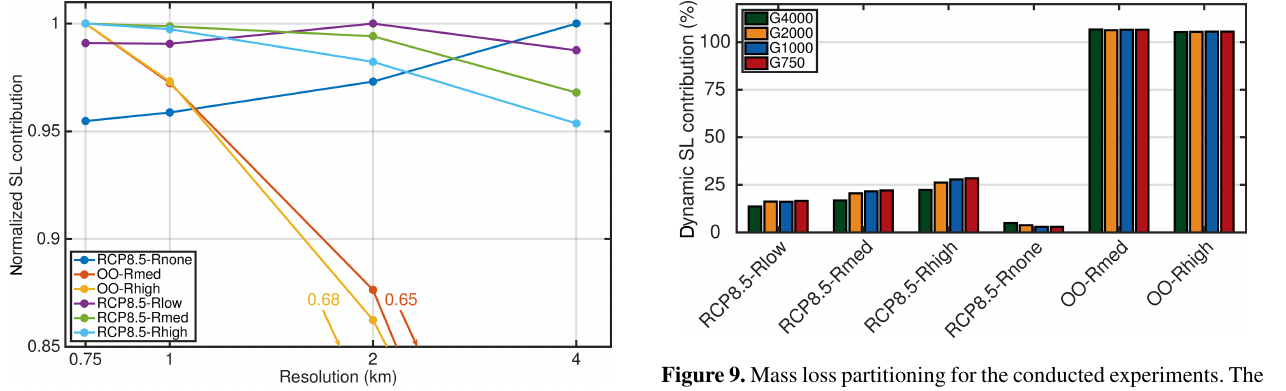
Figure 8. Projected sea-level contribution in 2100 of the Greenland ice sheet as a function of the horizontal grid size. Values are nor- malized to the maximum of each experiment (coloured lines). Note the logarithmic scale of the x axis.